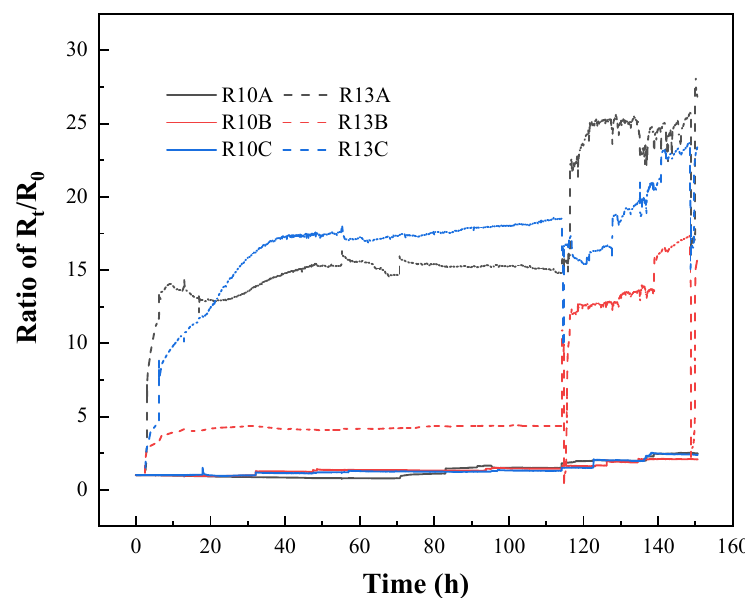
Figure 11. Electric resistance changes of R10 and R13 in the three layers during CH 4 gas seeping.